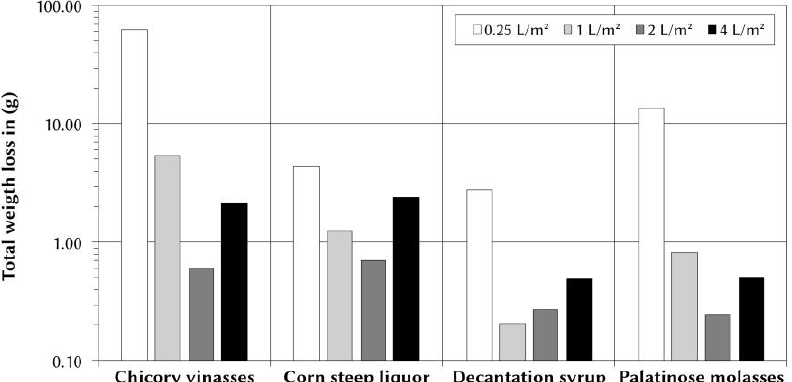
Figure 4. Wind-induced total weight loss (g) of treated mine soils wetted with four different rainfall intensities after four wet–dry cycles (mean values, n = 3). By comparison, untreated soil showed a total weight loss of 125.28 g after four measuring